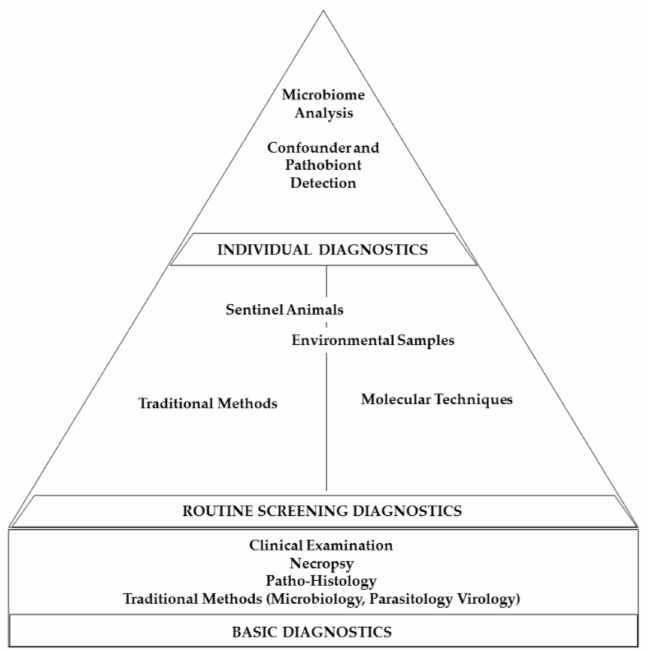
Figure 3. Diagram depicting the different proportions of HM programs. Basic diagnostic methods should build a solid foundation, and routine diagnostic screening procedures should form the main body of HM concepts, supplemented by individual diagnostic